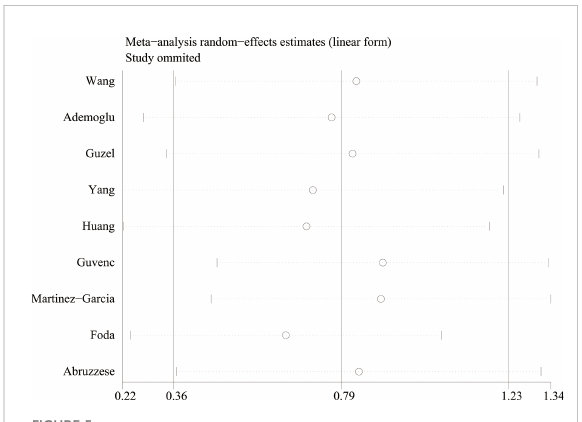
FIGURE 5 The sensitivity analysis results of circulating chemerin levels in patients with polycystic ovary syndrome compared with